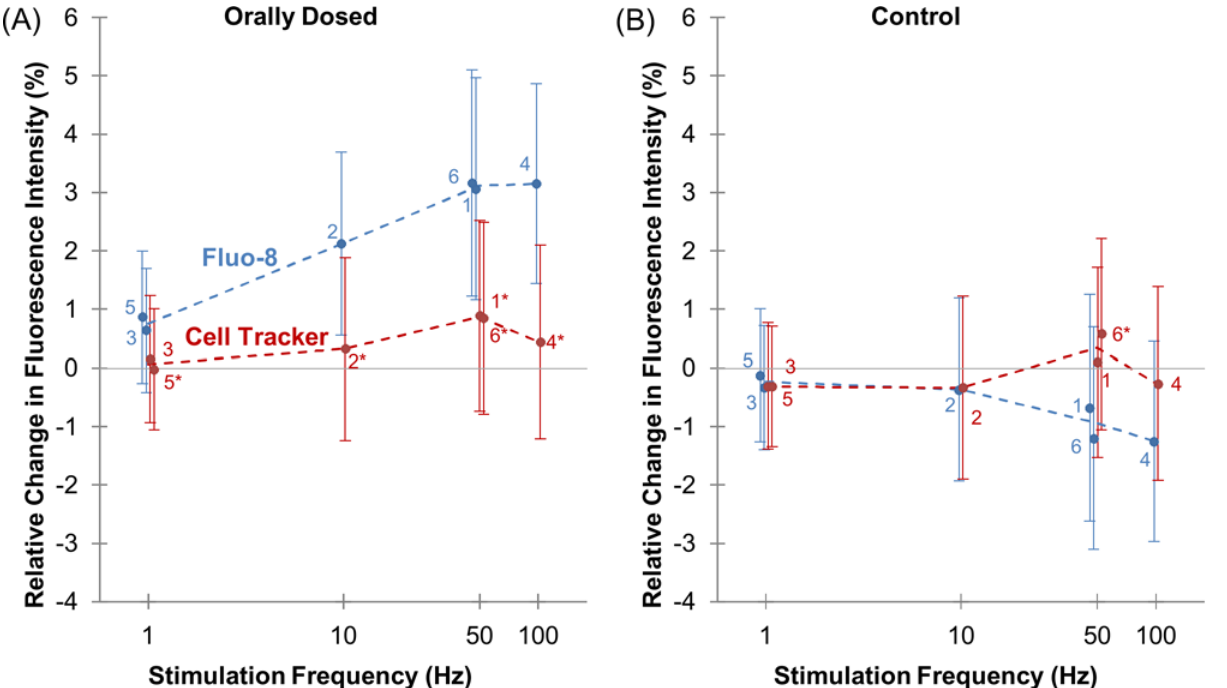
Figure 5. Relationship of Ca 2+ dynamics with electrical stimulation frequency. Relative changes in fluorescence intensity (( Δ F / F 0 )×100%) for leg muscle of (A) beetle orally dosed with Fluo-8 (blue) and Cell Tracker (red) and (B) control beetle measured with the filter setting used for Fluo-8 (blue) and Cell Tracker (red) under varying electrical stimulations (1 Hz, 10 Hz, 50 Hz, and 100 Hz; 10% duty cycle; 2 V). Data were analyzed from the ROI adjacent to the stimulated site (S1B Fig.). The error bars represent the S.D. (N = 8 beetles, n = 24 beetle legs for (A); N = 2 beetles, n = 8 beetle legs for (B)). The small numbers next to each plot indicate the order of stimulation. Cell Tracker data set was compared with Fluo-8 data set at each stimulation frequency evaluated by student ’ s t-test both for dosed beetles in (A) (1st 50 Hz, p = 9.37×10 -4 ; 10 Hz, p = 7.45×10 -3 ; 1st 1 Hz, p = 2.30×10 -1 ; 100 Hz, p = 4.17×10 -4 ; 2nd 1 Hz, p = 4.49×10 -2 ; and 2nd 50 Hz, p = 8.16×10 -3 ) and for control beetles in (B) (1st 50 Hz, p = 4.10×10 -1 ; 10 Hz, p = 9.30×10 -1 ; 1st 1 Hz, p = 9.29×10 -1 ; 100 Hz, p = 5.69×10 -2 ; 2nd 1 Hz, p = 6.85×10 -1 ; and 2nd 50 Hz, p = 2.67×10 -2 ). The significant differences are displayed by an asterisk (p < 0.05). Fluo-8 intensity dynamics show that Ca 2+ dynamics inside the muscle have a positive correlation with electrical stimulation frequency; i.e., higher stimulation frequency induces larger increase in [Ca 2+ ]. On the other hand, Cell Tracker intensity dynamics show that the frequency-dependent intensity change due to muscle displacement is not apparent.